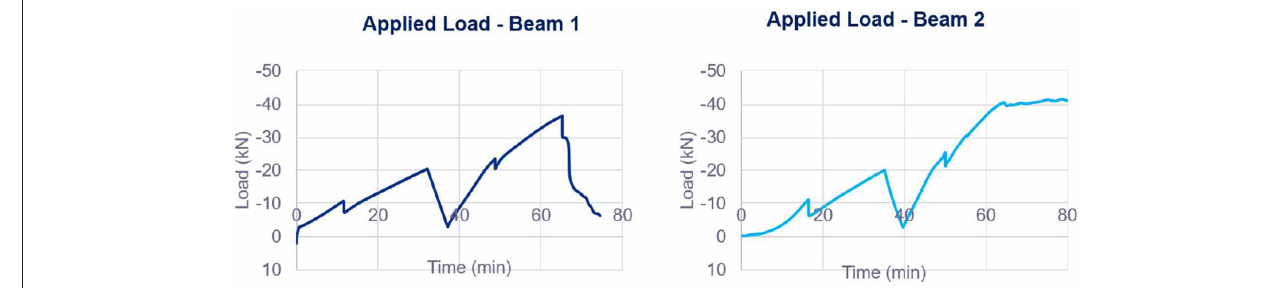
FIGURE 2 | Load scheme applied to each beam specimen.